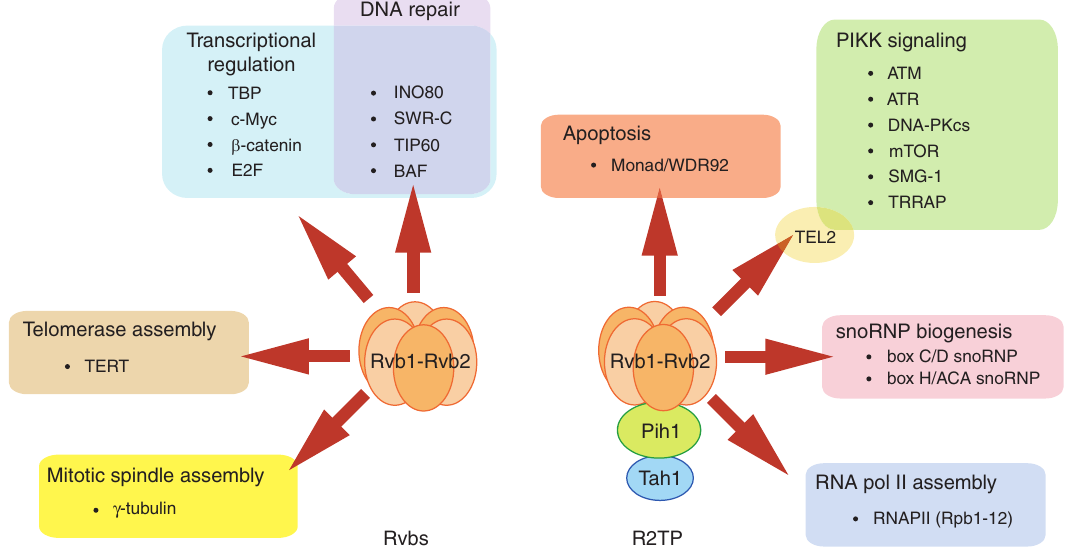
Figure 1 Functions of Rvbs (Rvb1-Rvb2) and R2TP